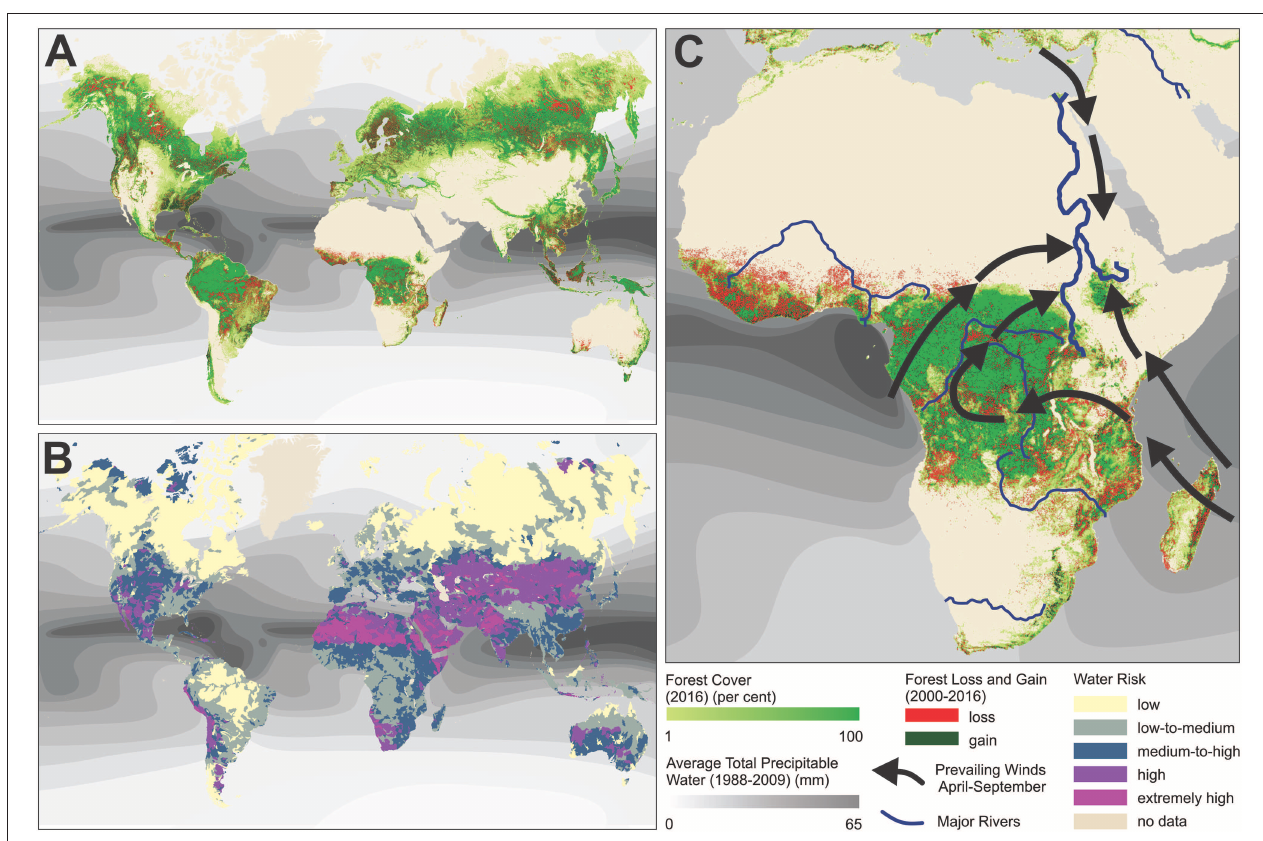
FIGURE 1 | A large amount of forest cover (A) typically coincides with low water risk (B) . Forests provide source water to the atmosphere that can be transported and redistributed via prevailing winds to areas of high-water risk to reduce drought vulnerabilities. Thus, the loss of forests in one area will have localized, regional, and global effects on water availability. For example, (C) those living within the Nile River watershed in northern Africa depend on water from the Nile River, but the precipitation that feeds the Nile depends, in part, on evapotranspiration from west and east Africa Africa [wind vector and average annual total precipitable water data are shown for the main rainy season (April-September)]. [Data Sources: ( Hansen et al., 2013); World Resources Institute 1 ; NASA Water Vapor Project (NVAP) 2